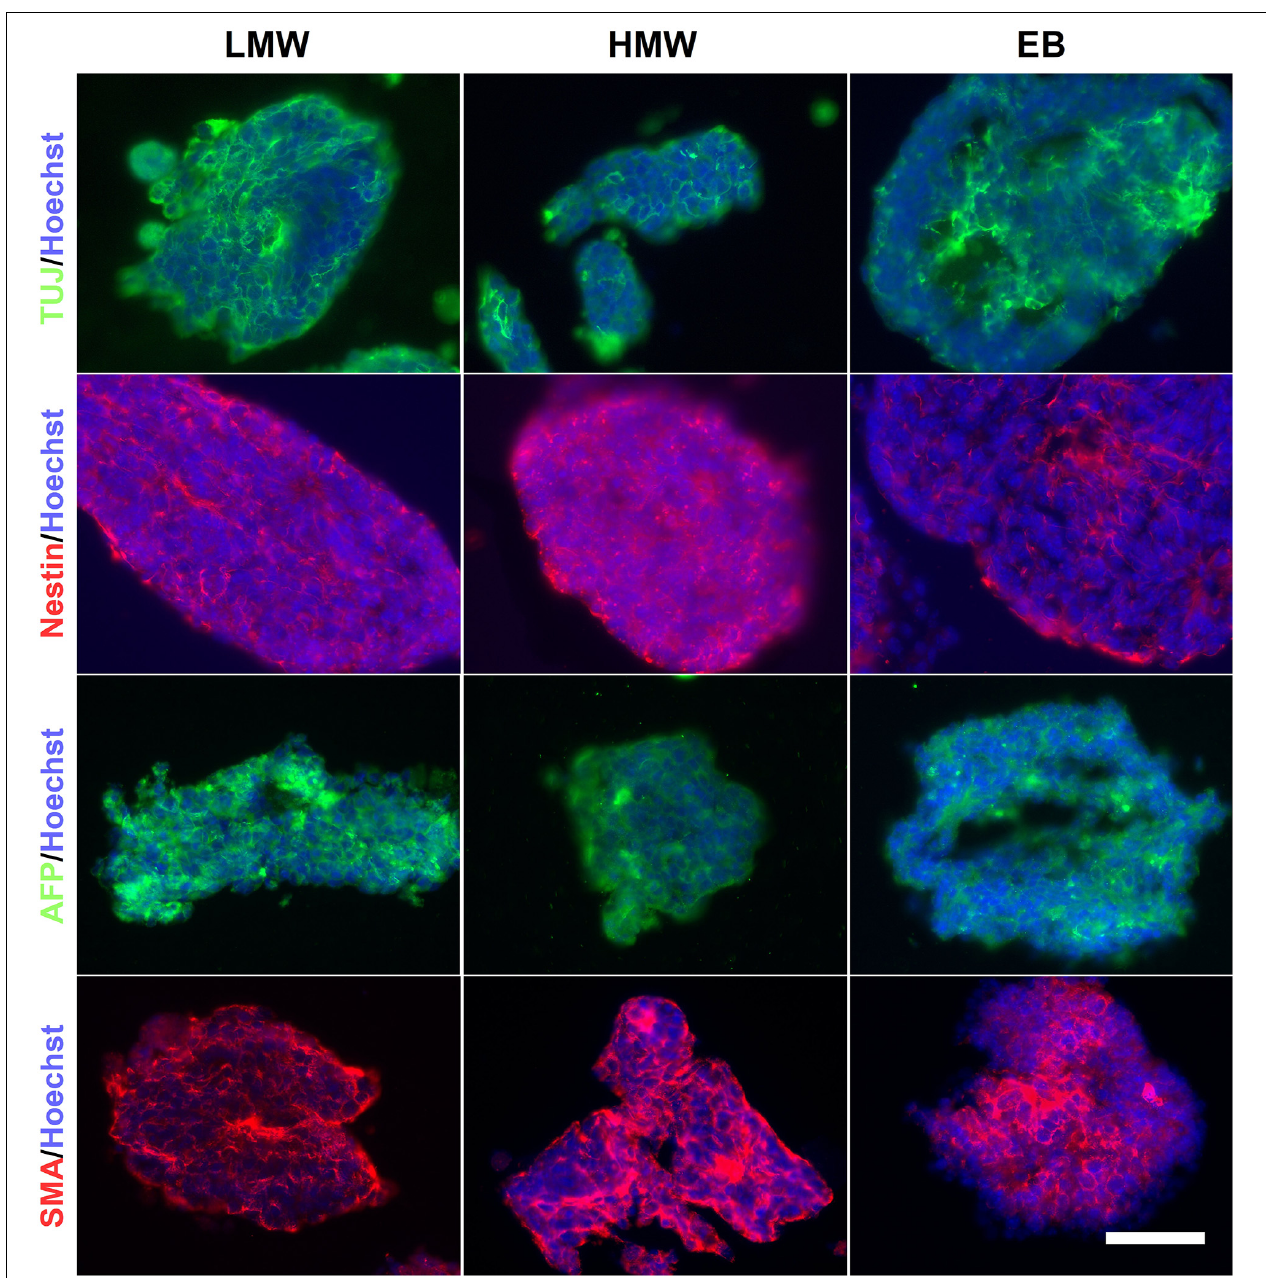
FIGURE 5 | EBs and alginate beads contain cells from the three germ layers. Encapsulated aggregates in LMW and HMW alginate beads and EBs are positive for β III-tubulin (TUJ1), Nestin, AFP, and SMA indicating the presence of the three germ layers. Scale Bar: 50 µ m.